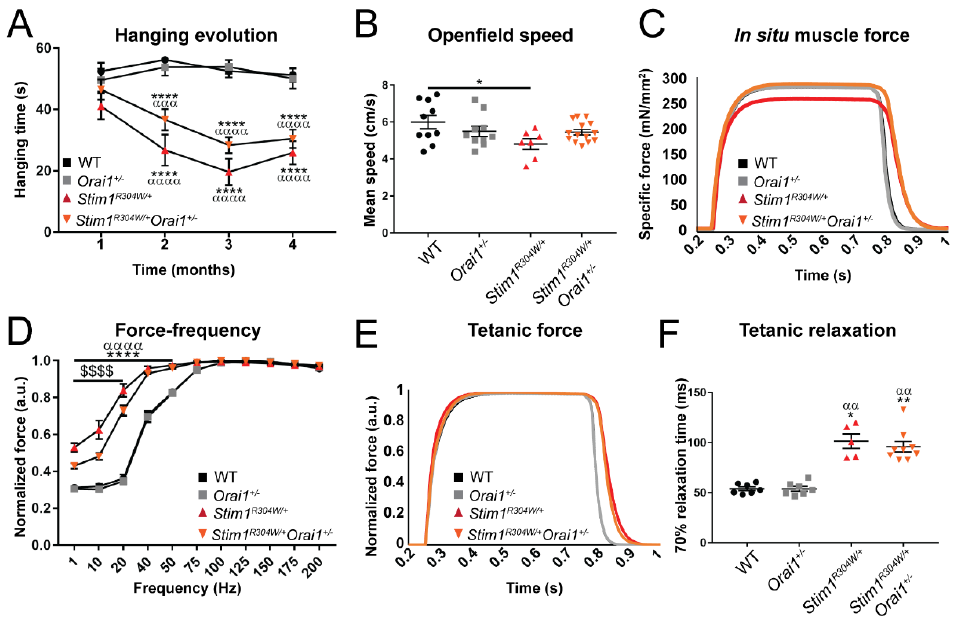
Figure 2. Partially improved muscle performance of Stim1 R304W/+ Orai1 +/ − mice. ( A ) Stim1 R304W/+ Orai1 +/ − mice showed a continuous but not significant tendency of increased hanging times compared with Stim1 R304W/+ littermates between 1 and 4 months (n = 11–17). ( B ) The velocity of Stim1 R304W/+ Orai1 +/ − mice in the open field arena was indistinguishable from WT and Orai1 +/ − con- trols at 10 weeks of age and slightly but not significantly improved compared with Stim1 R304W/+ lit- termates (n = 7–14). ( C ) In situ measurements at 8 months revealed an increased specific muscle force of Stim1 R304W/+ Orai1 +/ − compared with Stim1 R304W/+ mice at 100 Hz (n = 5–7). ( D – F ) Stimulation frequencies of 1–200 Hz evidenced a significant shift of the Stim1 R304W/+ Orai1 +/ − muscle contraction properties towards normal values, while muscle relaxation following tetanic stimulation at 100 Hz was similar in Stim1 R304W/+ and Stim1 R304W/+ Orai1 +/ − mice (n = 5–9) The curves in 2E are normalized to facilitate the comparison of muscle contraction and relaxation kinetics. Graphs represent mean ± SEM. Significant differences are indicated as */ α /$ p < 0.05, **/ αα /$$ p < 0.01, ***/ ααα /$$$ p < 0.001, and ****/ αααα /$$$$ p < 0.0001 with * reflecting the comparison with the WT group, α the comparison with the Orai1 +/ − group, and $ the comparison with the Stim1 R304W/+ Orai1 +/ − group. Muscle contraction is a multistep process initiated by an electrical stimulus and me- diated by the release of Ca 2+ from the SR. The Ca 2+ ions trigger the shortening of the con- tractile units to generate force [30], and Ca 2+ store refill through the ATP-dependent SERCA pumps enables muscle relaxation and maintains high Ca 2+ gradients across the SR membrane to allow repetitive tetanic stimulations and counteract the effects of fatigue [31,32]. As a consequence of the Ca 2+ abundance at the contractile units, Stim1 R304W/+ mice manifest an increased force production at low stimulation frequencies together with a de- lay in muscle contraction and muscle relaxation, which results in abnormal fatigue pro- files and possibly corresponds to the muscle cramping phenotype observed in TAM/STRMK patients [10,21,23]. In Stim1 R304W/+ Orai1 +/ − mice, the force production between 1 and 20 Hz and the muscle contraction kinetics following a single impulse distinctively shifted towards the WT values without reaching normalization (Figures 2D–F and S3A,B), and we also noted a non-significant tendency of ameliorated muscle relaxation (Figure S3A,C). The fatigue curves following repetitive stimulations however remained identical in Stim1 R304W/+ Orai1 +/ − and Stim1 R304W/+ mice, suggesting unresolved muscle cramping (Fig- ure S3D–G). In summary, the reduction of Orai1 expression by half has measurable and in parts significant effects on specific muscle force and functionality parameters in Stim1 R304W/+ Orai1 +/ − mice.